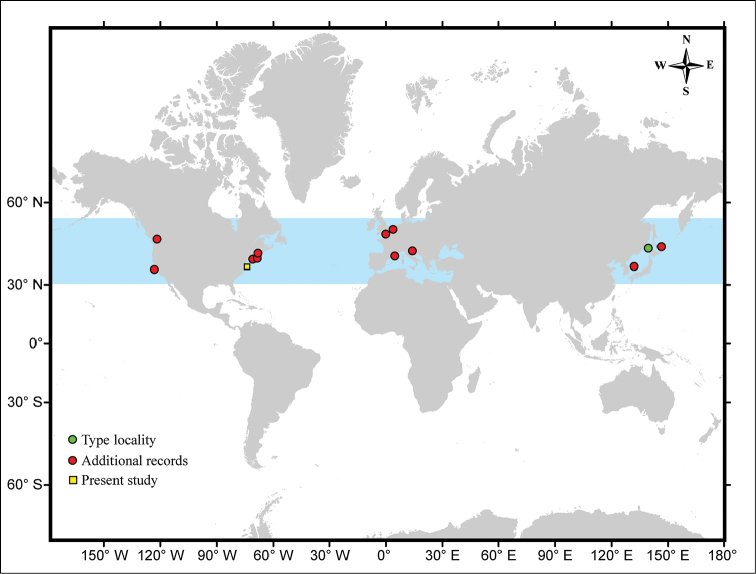
Map showing the worldwide distribution of Ianiropsis
serricaudis and I.
cf.
serricaudis. Ianiropsis
serricaudis – type material (green circle), I.
serricaudis – additional records (red circle), I.
cf.
serricaudis (yellow square). Data from: Gurjanova (1936); Kussakin (1962, 1988); Jang and Kwon (1990); Hobbs et al. (2015); Marchini et al. (2016); Ulman et al. (2017); Morales-Núñez and Chigbu (this study).